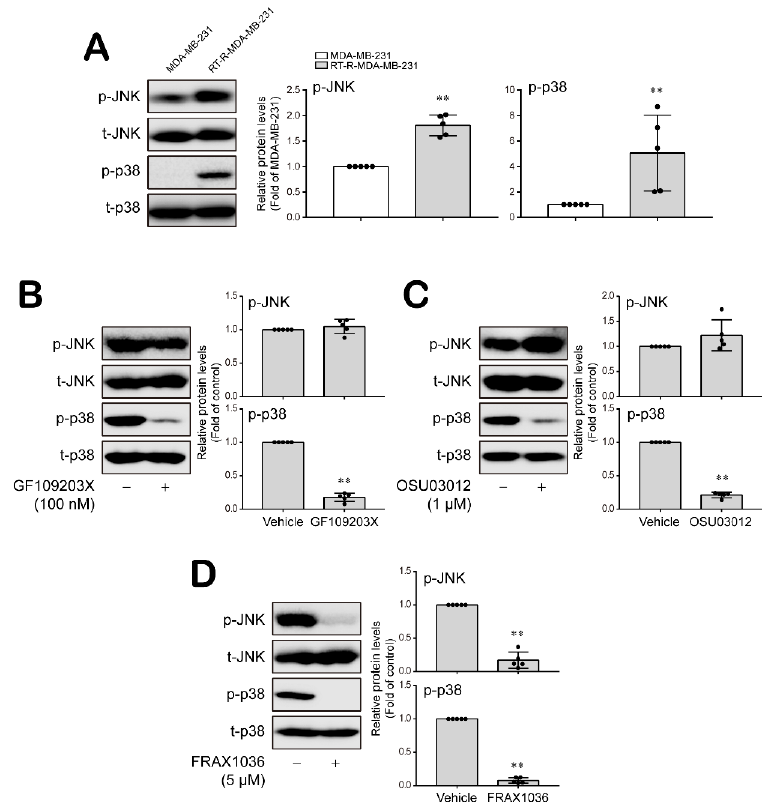
Figure 3. JNK and p38 MAPKs were differentially regulated by PKC, PDK1 and PAK1 in RT-R- MDA-MB-231 cells. ( A ) Phospho- and total JNK or p38 protein expression levels were analyzed with extracted proteins from MDA-MD-231 and RT-R-MDA-MB-231 cells by Western blotting. The re- sults are presented as the mean ± SD of five independent experiments. ** p < 0.01 compared to the MDA-MB-231 cells. ( B – D ) RT-R-MDA-MB-231 cells were treated with GF109230X (100 nM; a PKC inhibitor, for 15 min), OSU03012 (1 µM; a PDK1 inhibitor, for 30 min) and FRAX1036 (5 µM; a PAK1 inhibitor, for 10 min), and then protein was collected from the cells. Phospho- and total JNK or p38 protein levels were analyzed by Western blotting. The values are presented as the mean ± SD of five independent experiments. ** p < 0.01 compared to the control.